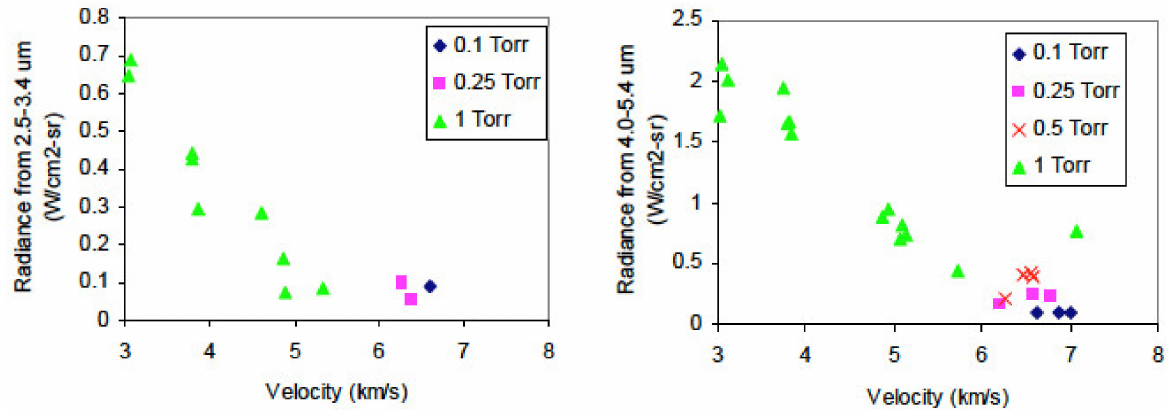
Figure 30. Radiation behind the shock for Mars entry conditions, at different velocities and pressures (left: 2700 nm band, right 4300 nm band) (from